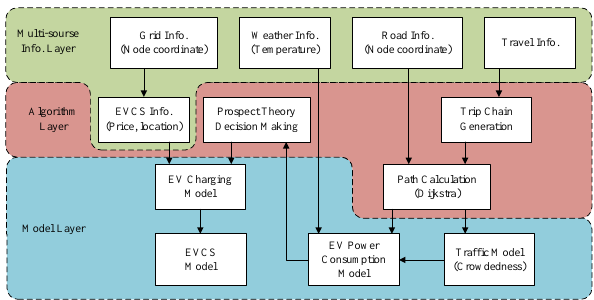
Figure 1. Framework of multi-source information interaction system.